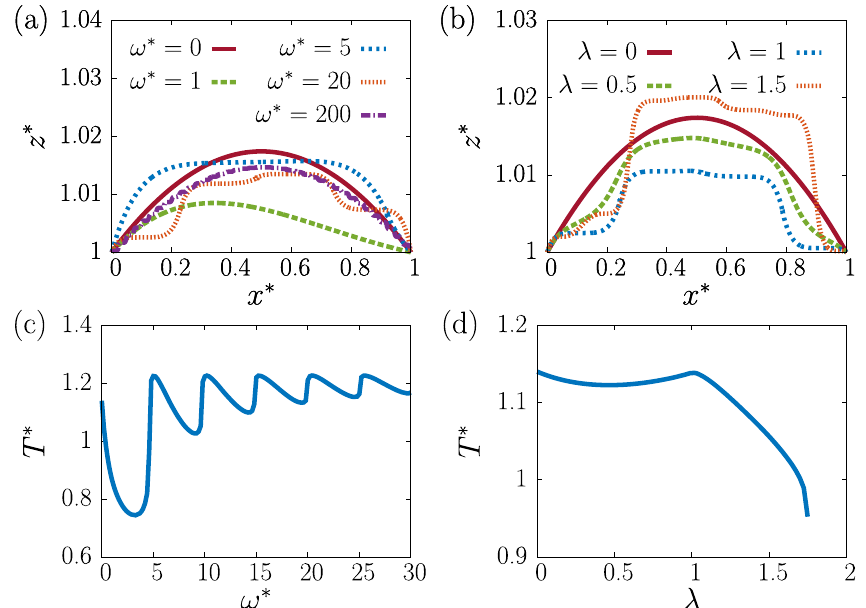
Fig. 5 Time-dependent microswimmer navigation. Optimal trajectories and travel times of time-dependent source dipole microswimmers for fi xed amplitude λ = 1 and different dimensionless frequencies ω * = ωτ shown in the key ( a , c ) and for fi xed ω * = 6 π and different λ ( b , d ). The shown travel times, T * = T / τ , for the optimal trajectory are always shorter than when choosing the shortest path to the target. Here, lengths and times are made dimensionless by ℓ and τ ,